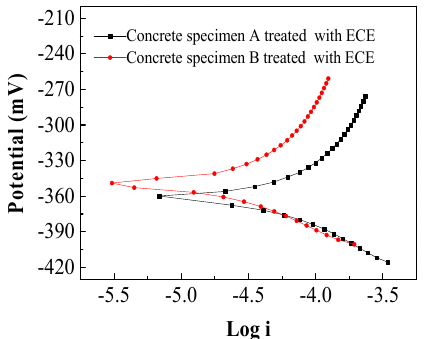
Figure 4. Polarization curves of a steel bar in concrete treated with electrochemical chloride extraction (ECE).